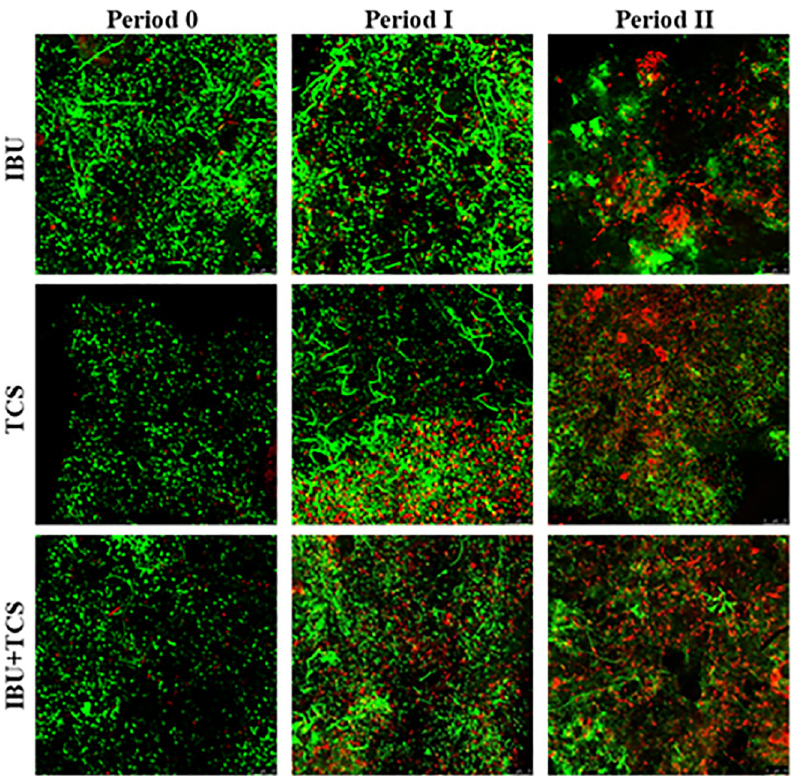
Fig 4. Live/Dead confocal micrographs (scale bar 10 μ m) of activated sludge exposed to individual pharmaceuticals (ibuprofen, IBU, and triclosan, TCS) and their mixtures (IBU+TCS) at different time exposure. Period 0 (control); Period I (7 days) and Period II (14